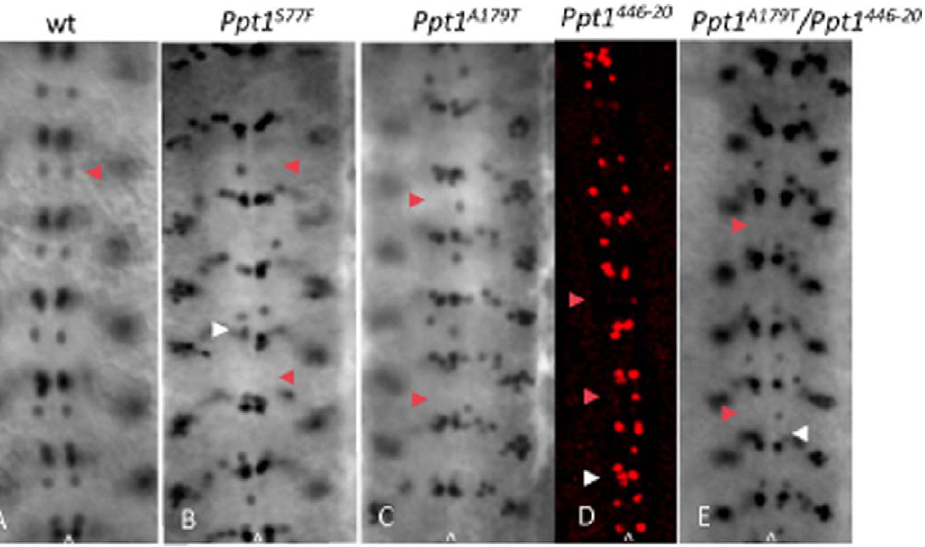
Figure 2. Loss of Ppt1 results in missing EVE + RP2 neurons in many hemisegments of S16 embryonic CNS. Arrowhead indicates RP2 neuron in all panels. (A). Wild type EVE + CNS pattern. (B–E) Ppt1 LOF mutants exhibit a variety of phenotype including the loss of EVE + RP2s in some hemisegments (red arrowhead in B–E), disorganized or missing aCC/pCC clusters (white arrowhead in B, D and E). Anterior, up; caret, midline.